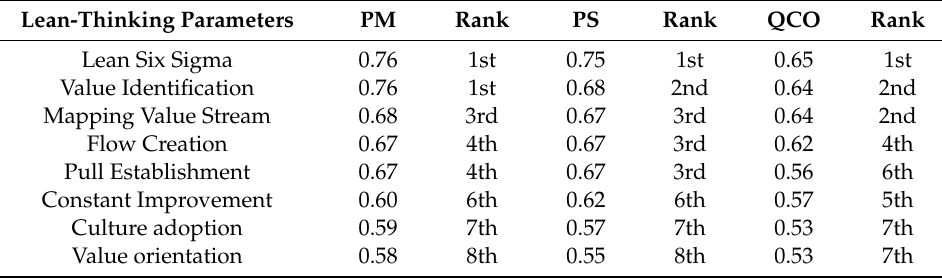
Table 4. Areas of lean thinking that influence Construction